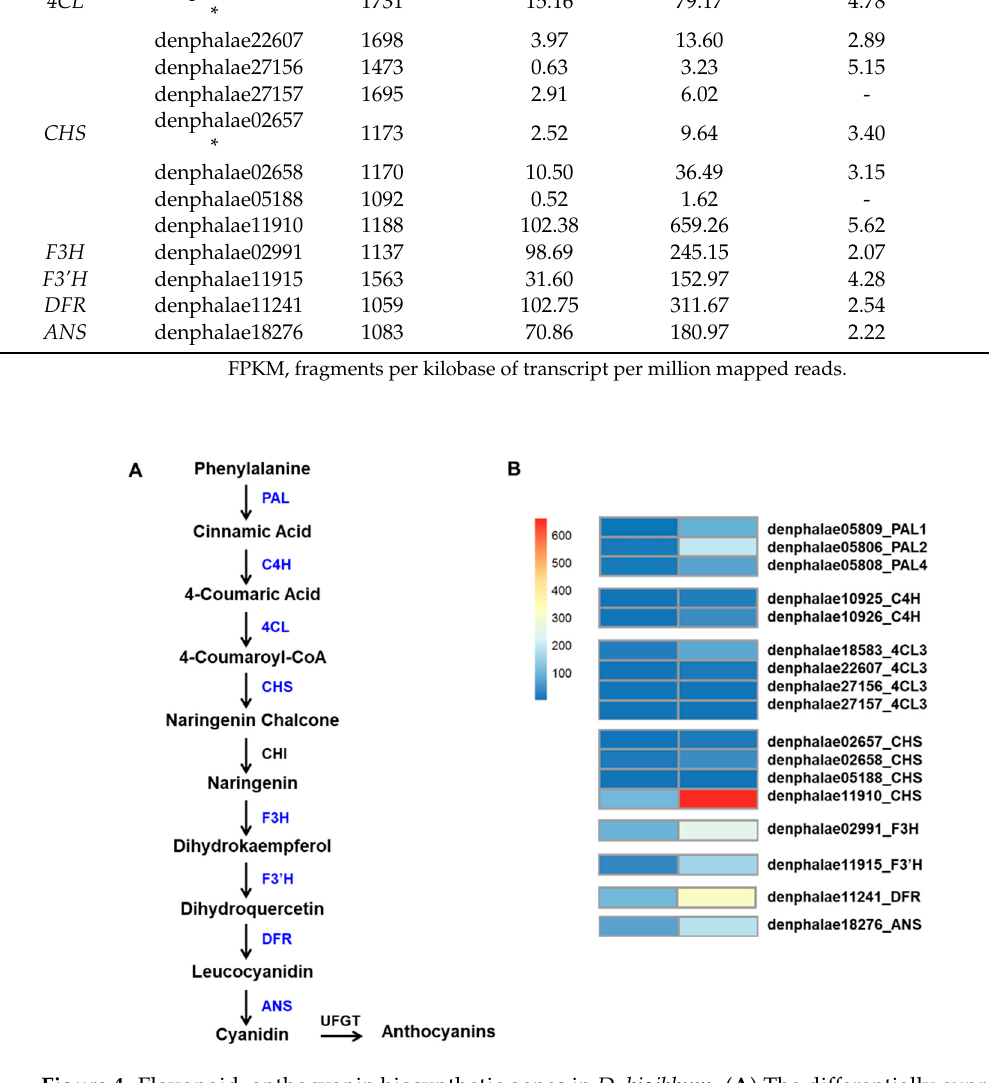
Figure 4. Flavonoid–anthocyanin biosynthetic genes in D. bigibbum . ( A ) The differentially expressed genes (DEGs) between the WT and RB016-S7 mutant found in leaves are highlighted in blue. Phenylalanine ammonia-lyase, PAL; cinnamic acid 4-hydroxylase, C4H; 4-coumarate CoA-ligase, 4CL; chalcone synthase, CHS; chalcone isomerase, CHI; flavanone 3-hydroxylase, F3H; flavonoid 3 ′ -monooxygenase, F3 ′ H; dihydroflavonol 4-reductase, DFR; and anthocyanidin synthase, ANS. ( B ) Expression profiles determined using fragments per kilobase of transcript per million mapped reads (FPKM) values obtained from RNA-Seq data. Expression values (as FRKM) were not scaled per row to allow the visualization of original FPKM values among samples. The heatmap was generated using the R package pheatmap.